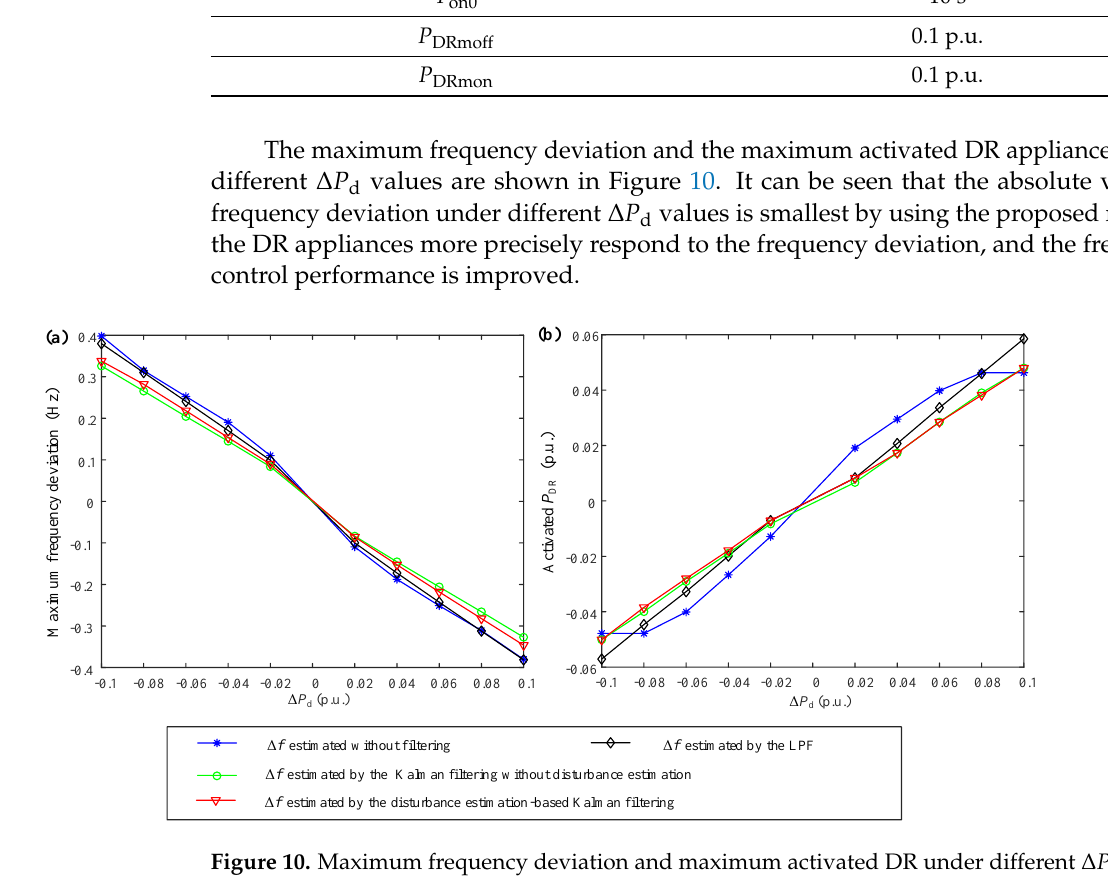
Table 3. Parameters for DR. Parameters Value K reoff 0.0012 p.u./s